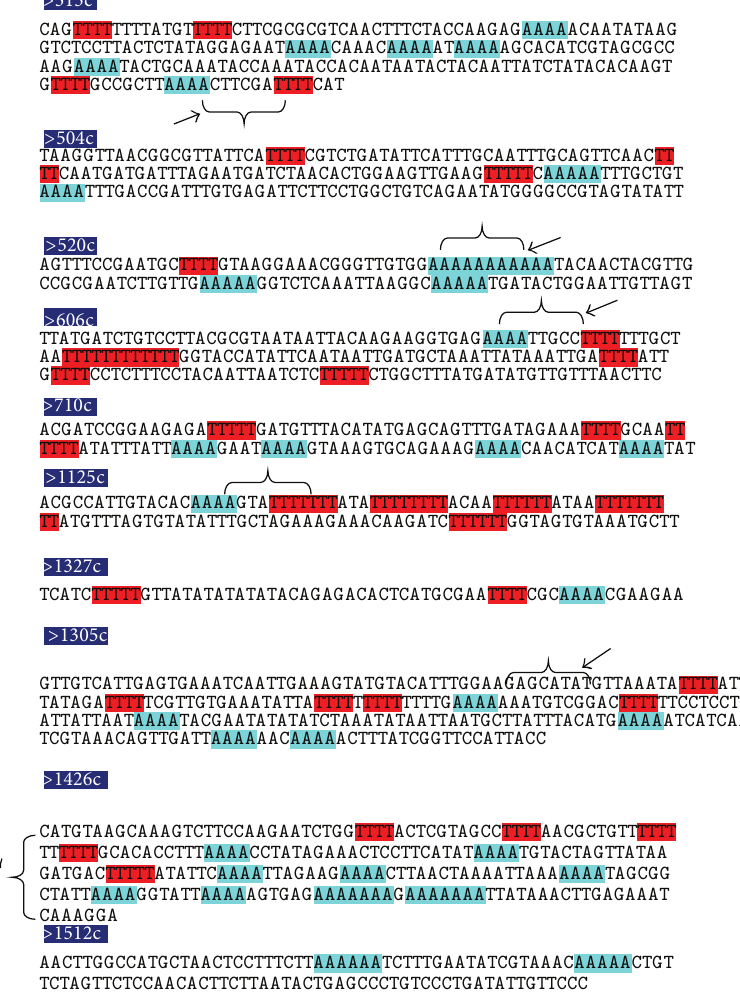
Figure 6: Nucleotide repeat pattern search in S. cerevisiae ARS elements. Sequences of the highest curvature regions of the S. cerevisiae ARS elements. The tetranucleotide repeats of “T” are shown in red ink, while those of “A” are shown in green ink.